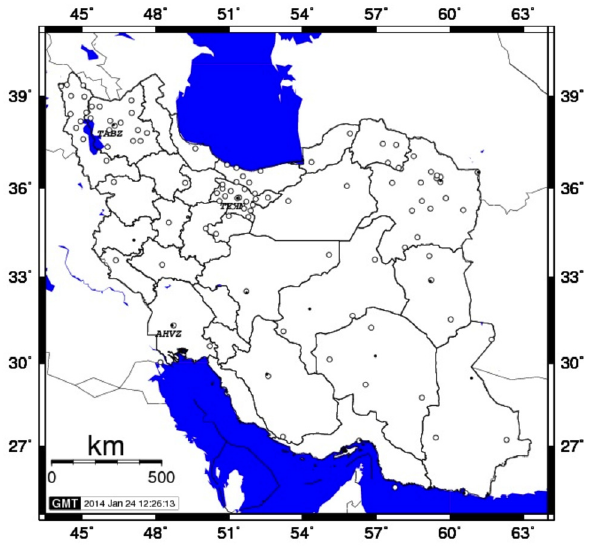
Figure 1. Position of the radiosonde stations (solid) and the perma- nent GPS stations in Iran (circles). The position of the IGS stations TEHN, AHVZ and TABZ is shown by a solid circles and names